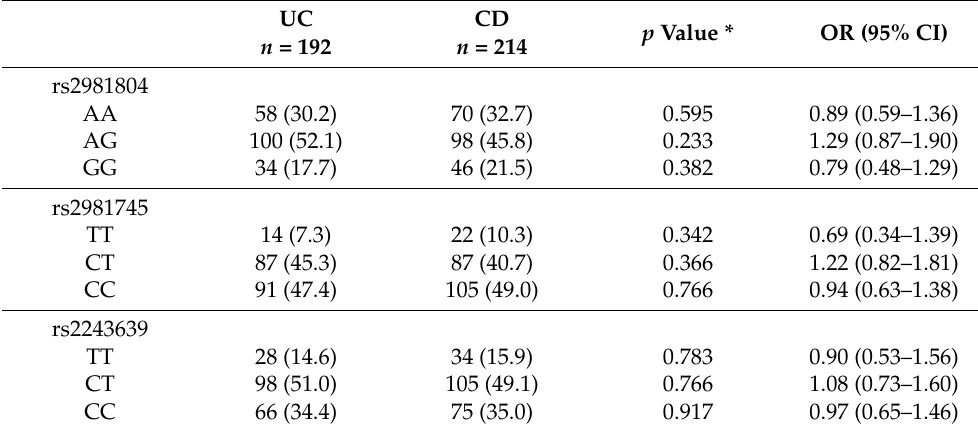
Table 1. DMBT1 (rs2981804, rs2981745) and SFTPD (rs2243639) genotype